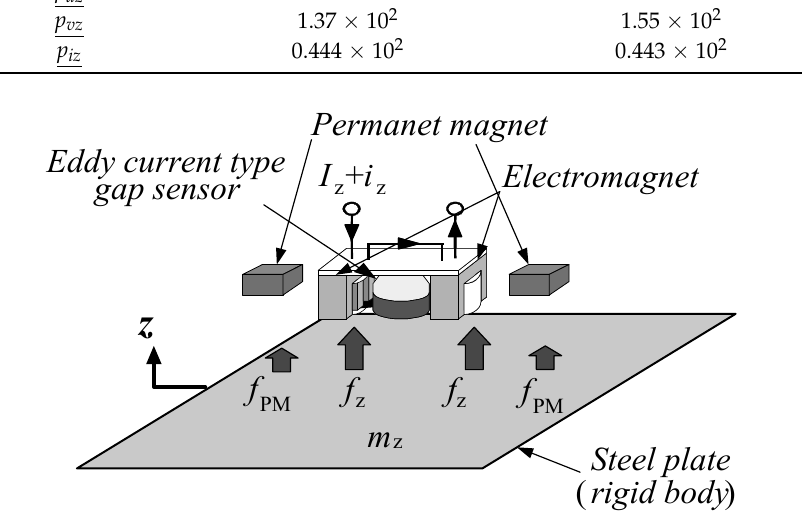
Figure 3. Modeling of levitation control for one electromagnet unit by lumped parameter system.